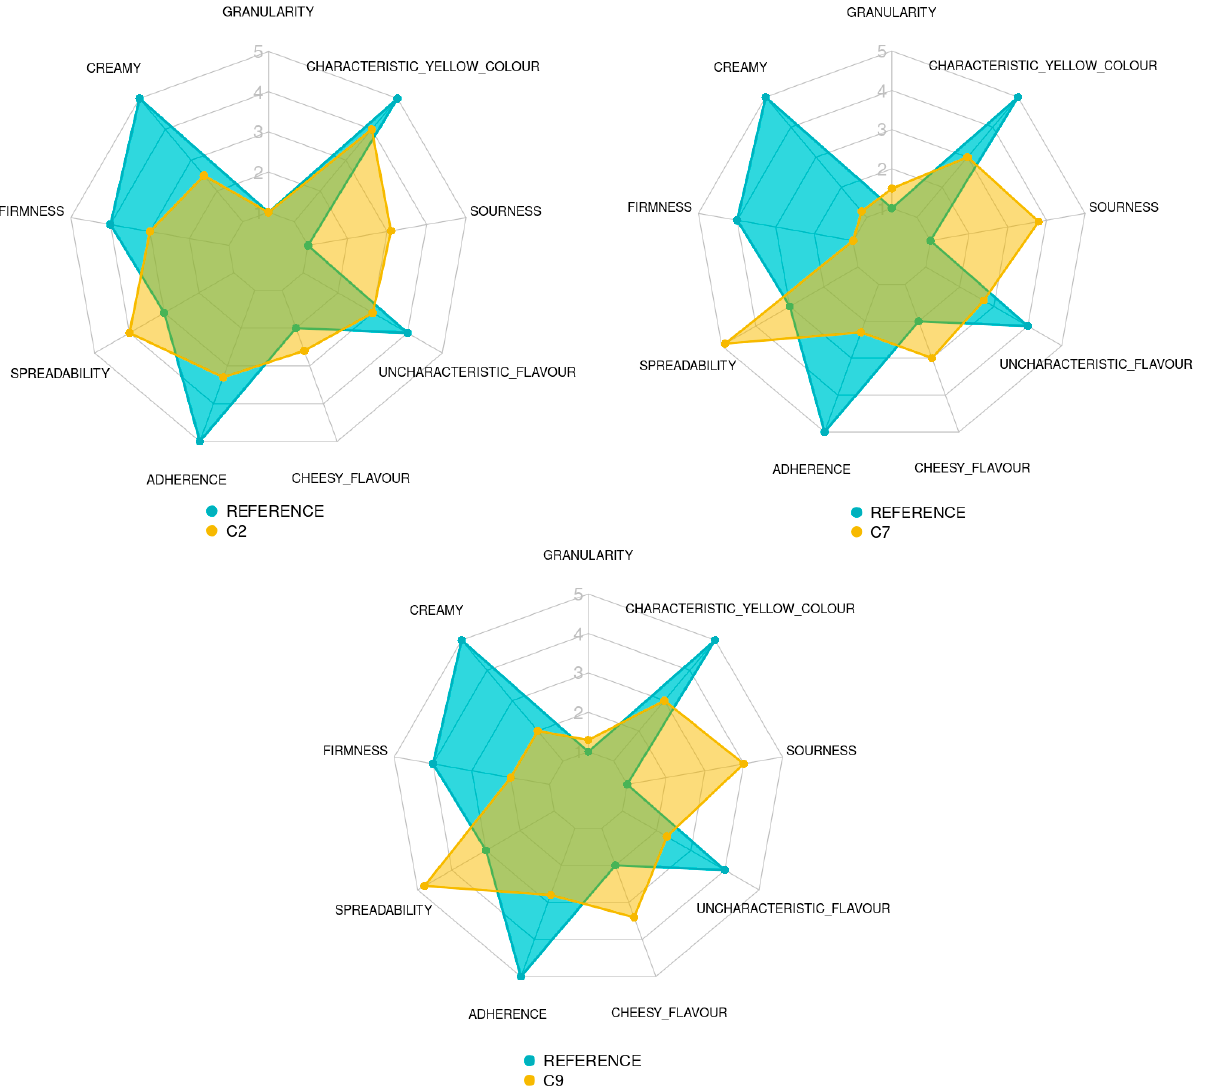
Figure 5. Spider charts showing the sensory results obtained by the trained panel for each a tt ribute of the 3 spreadable cheese analogues and the QDA reference (a commercial dairy cheese and plant-based cheese). MPC/FBP/IF ratio: C2 (50/50/0), C7 (25/50/25) and C9 (50/25/25).